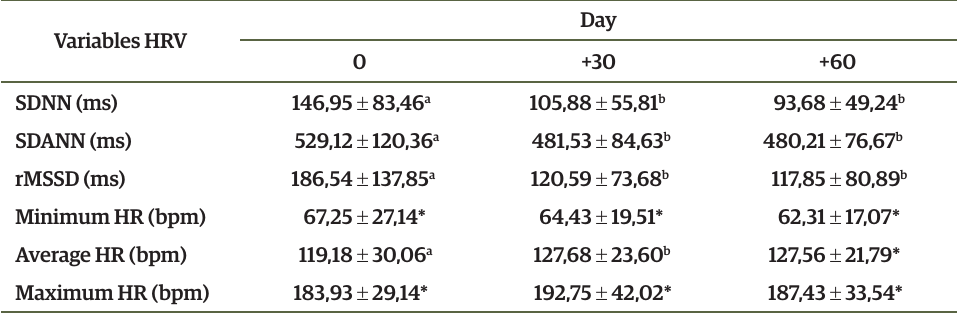
HRV: Heart Rate Variability; SDNN: standard deviation of all normal RR intervals of the exam; SDANN: standard deviation of means of normal RR intervals measured every five minutes; rMSSD: square root mean of the sum of the squared difference of normal RR intervals adjacent to the whole examination; HR: Heart Rate; SD: Standard Deviation; ms: milliseconds; bpm: beat per minute. Different letters (“a” and “b”) along the same line indicate statistical difference at 5% level. Asterisks (*) along the same line indicate no statistical difference at the 5%